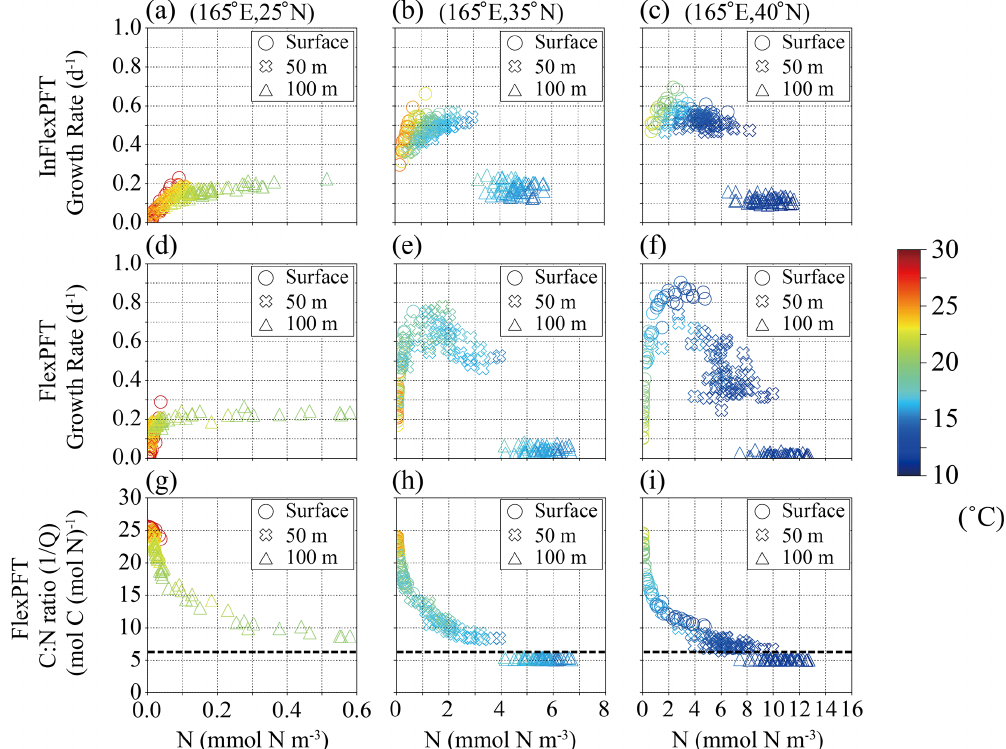
Figure 6. (a) – (f) Monthly mean phytoplankton growth rate (d − 1 ) in summer in 2000–2019 from Fig. 4c and d versus summer monthly mean N concentration (mmolNm − 3 ) from Fig. 2e and f for each depth (circles: surface, crosses: 50m depth, triangles: 100m depth in Fig. 4c and d) and each model, and (g) – (i) summer monthly mean C:N ratio versus summer monthly mean N concentration in the FlexPFT model. The colour in each figure represents the summer monthly mean T ( ◦ C) in Fig. 2h. Dashed lines in (g) , (h) , and (i) represent a constant C:N (106:16 = 6.625) ratio